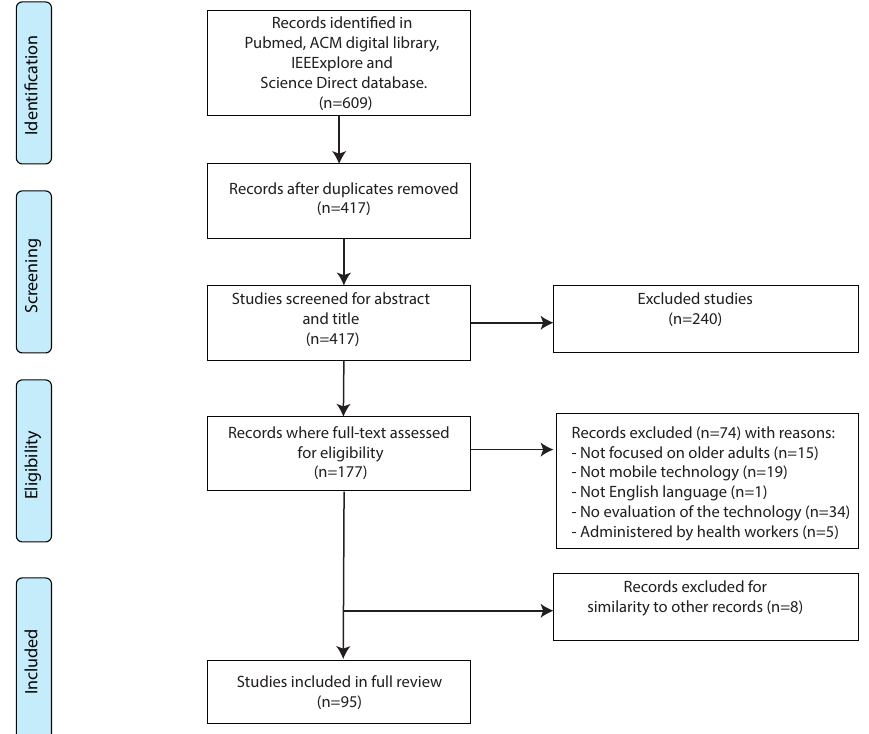
Figure 1. Flow-chart of the study selection